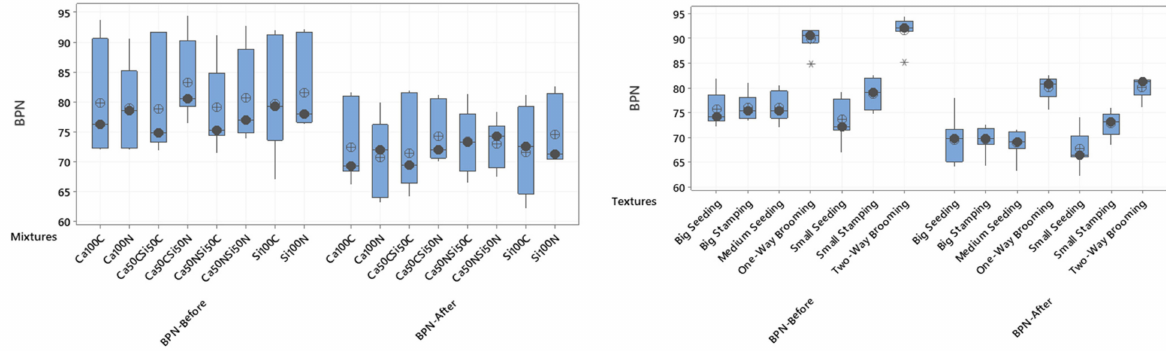
Figure 17. The BPN of different mixing proportions and different macro-textures before and after abrasion